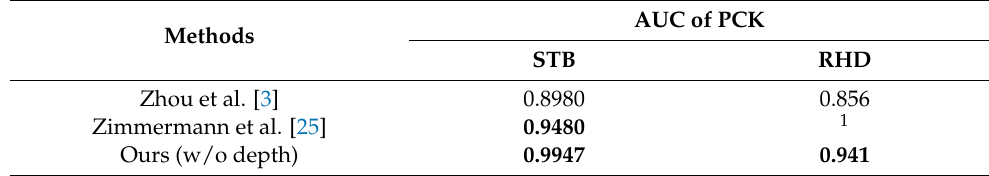
Table 2. Comparison with state-of-the-art single-RGB